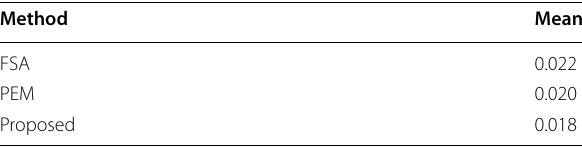
Table 10 Means of the power loss